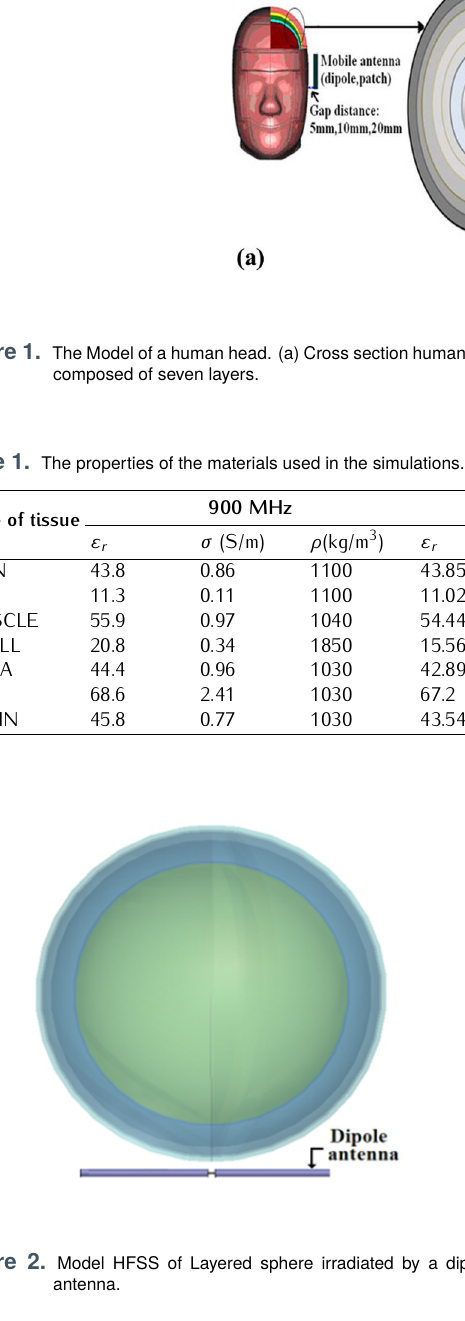
skin type, for the thickness 2 mm, for the fat a value of 1 mm, 4 mm for the muscle and 10 mm for the skull, dura 1 mm, csf 2 mm and the last layer is the brain as illustrated in Figure